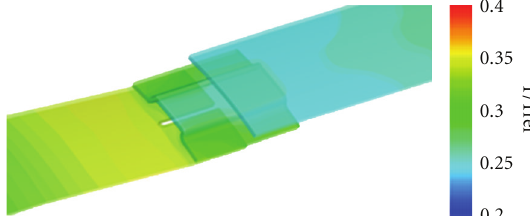
Figure 14: Temperature distribution over wiggle strip element at